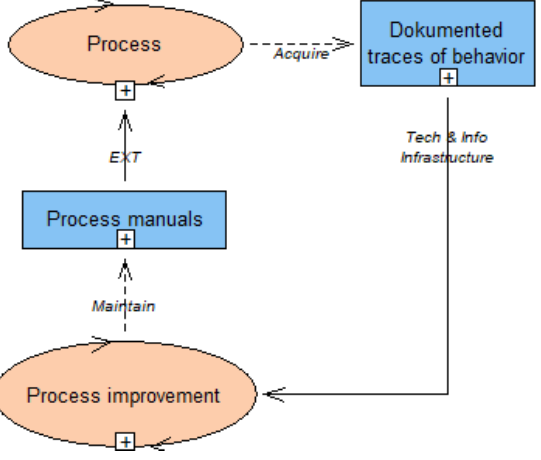
Figure 5. Negative feedback loop to restrain abnormal process